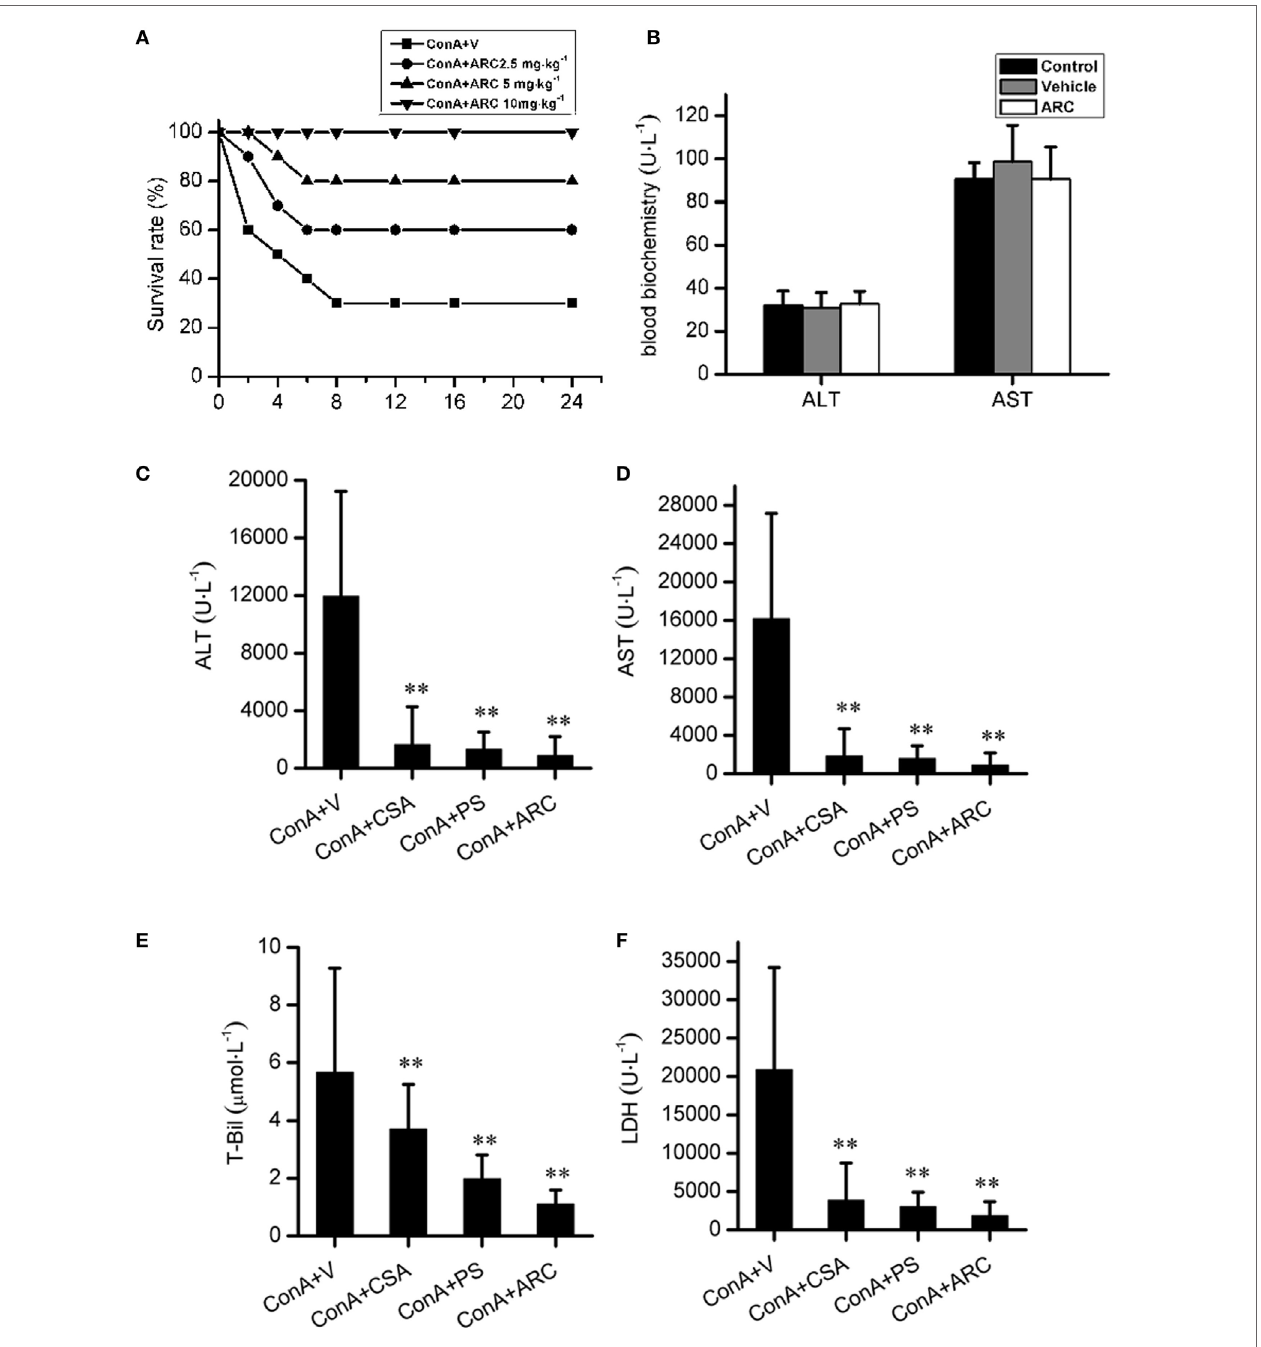
FigUre 4 | The protective effects of ARC on survival rates and liver function in ConA-induced hepatitis. ARC (2.5, 5, and 10 mg ⋅ kg − 1 ) pretreatment significantly increased survival rates after ConA (15 mg ⋅ kg − 1 ) administration (a) . In the presence of drugs or vehicle treatments twice per day for 10 days, the blood biochemical measurements showed that ARC or vehicle alone had no effects on normal liver functions (B) . CSA, PS, and ARC markedly decreased the serum levels of alanine transaminase, aspartate transaminase, TBIL, and lactate dehydrogenase at 12 h after ConA (10 mg ⋅ kg − 1 ) administration (c–F) . ** p < 0.01 compared with model group ( n = 8). The mice pre-treated with vehicle were used as model